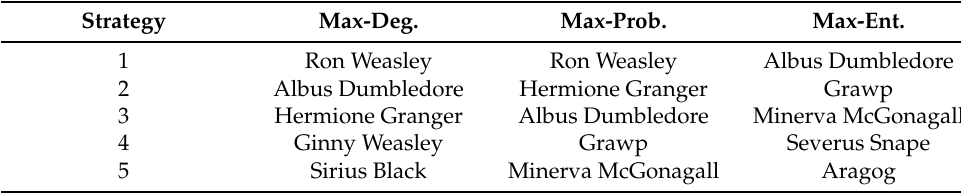
Table 1. Top 5 query selections for the three strategies of